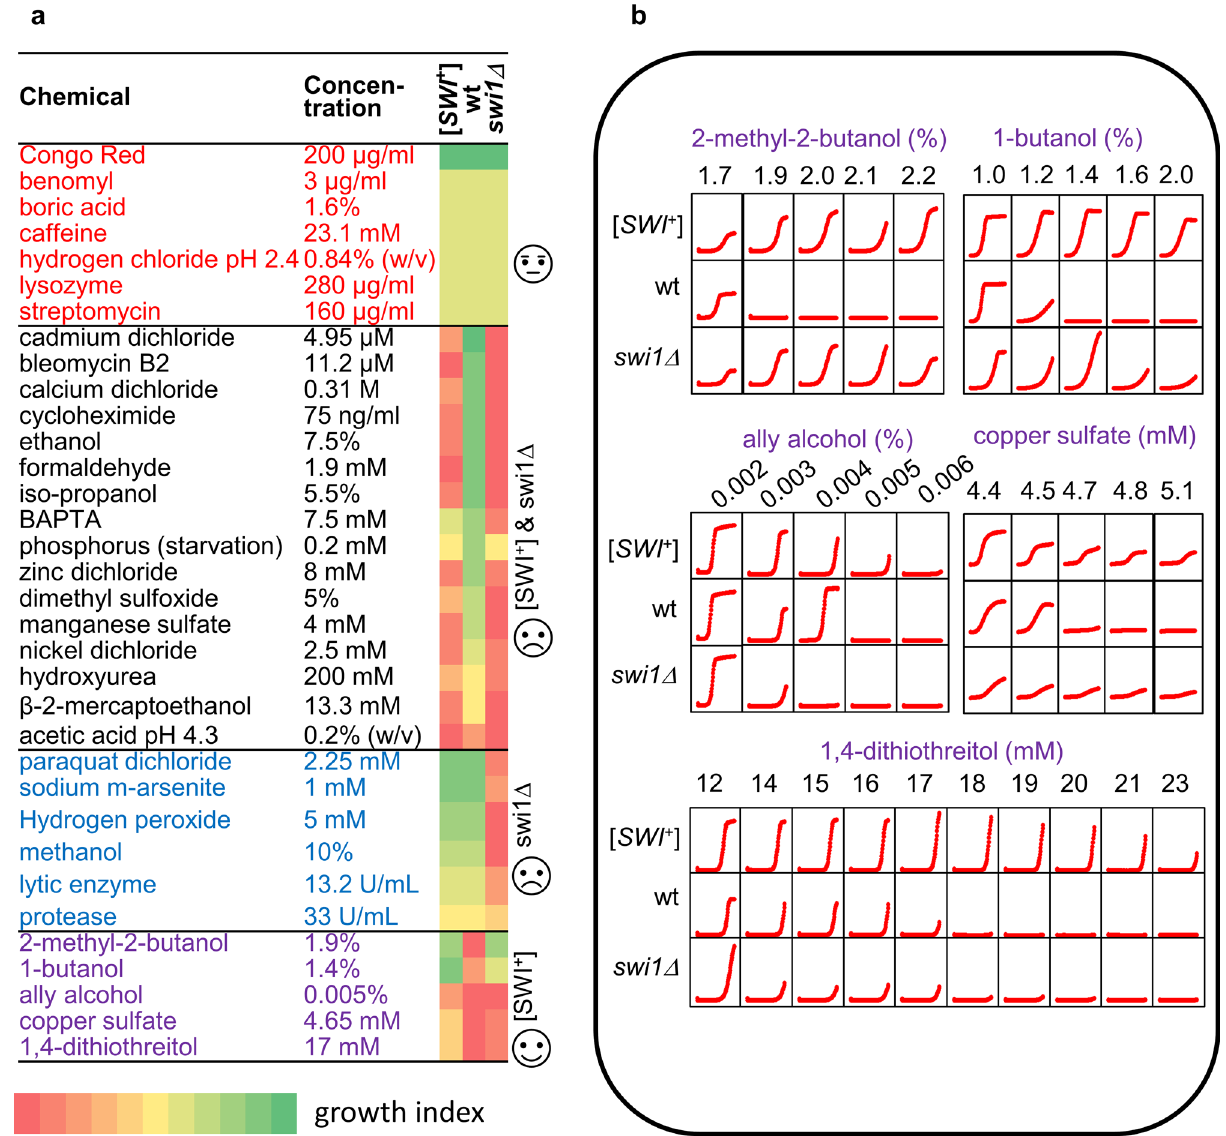
Figure 7. Growth analyses of the wt, [ SWI + ], and swi1∆ strains upon treatment of a panel of chemical stressors. ( a ) Cell growth in YPD supplemented with various amount of each indicated chemical stressor was monitored by a plate reader in a time window of 72 h. The growth index (colored as denoted) was determined based on data from at least three independent tests as described in the Methods. The tested chemical stressors were categorized into 4 subgroups (indicated by different text colors) based on the response patterns of the three strains. ( b ) For chemical stressors that display a beneficial effect on the fitness of [ SWI + ] cells (purple-colored in the panel a ), growth curves are shown for the three